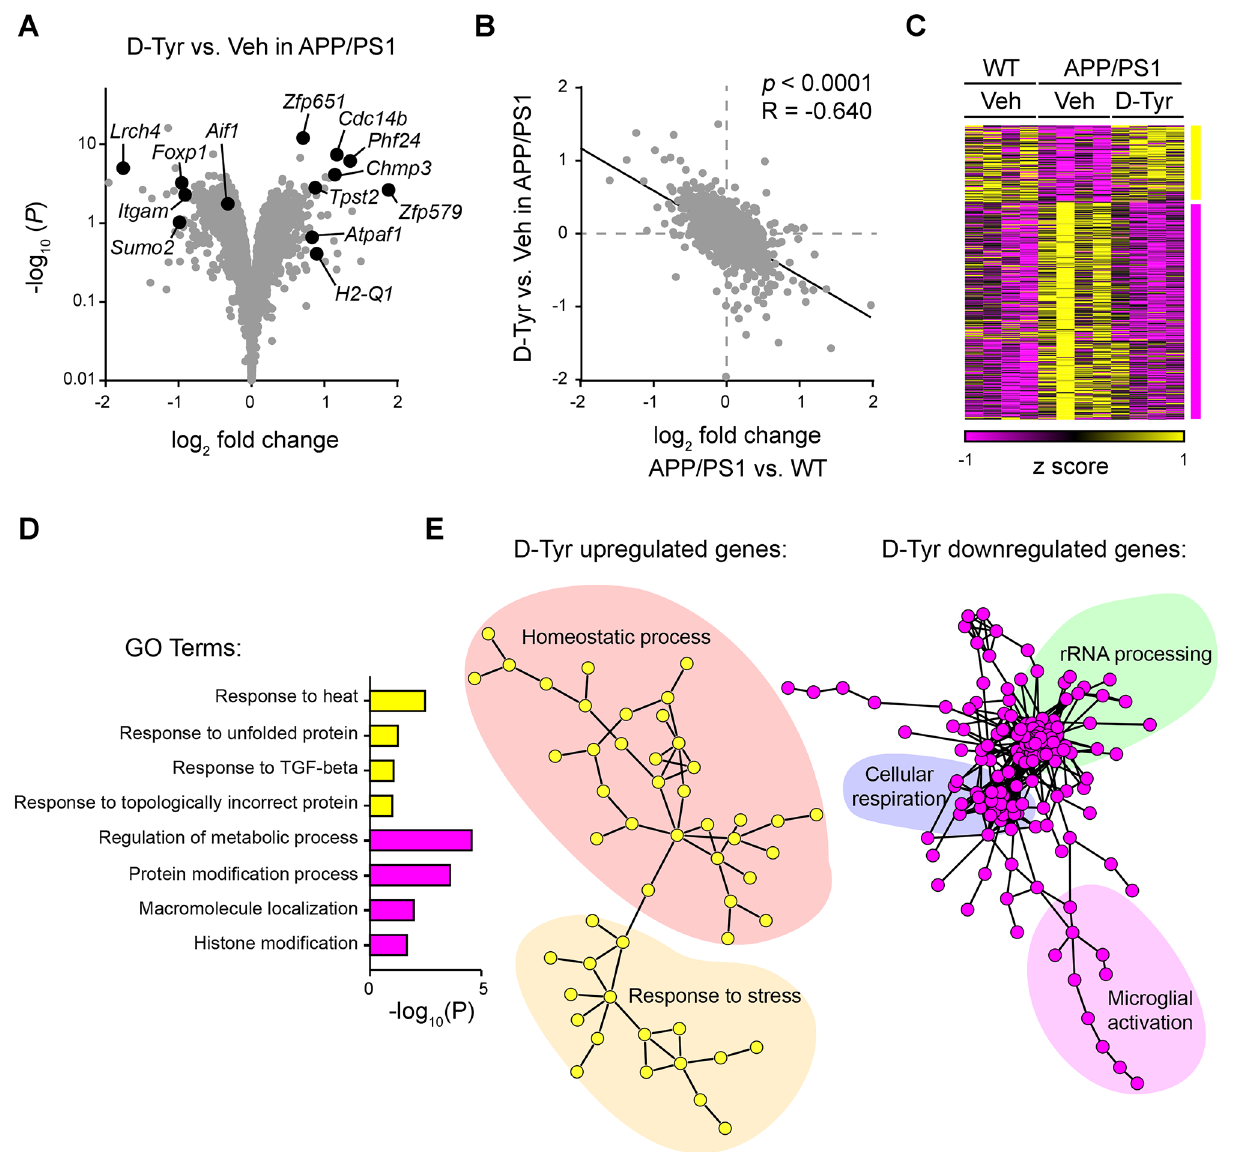
Figure 5. Administration of d-Tyr restores the dysregulated transcriptomic signature in APP/PS1 mice. ( A ) Volcano plot showing the differentially expressed genes (DEGs) upon d-Tyr administration in APP/PS1 mice. ( B – C ) d-Tyr administration reverted the transcriptomic changes in APP/PS1 mice. ( B ) Correlations between global transcriptomic changes of d-Tyr- versus vehicle (Veh)-treated APP/PS1 mice and APP/PS1 versus WT mice (r = − 0.64, p < 0.0001; linear regression). ( C ) Heatmap showing the expression levels of DEGs in d-Tyr- versus Veh-treated APP/PS1 mice, and Veh-treated WT mice. ( D – E ) Pathway analysis demonstrating the functional associations of d-Tyr–induced DEGs with stress response, rRNA processing, cellular respiration, and microglial activation. ( D ) Gene Ontology (GO) pathway analysis and ( E ) STRING protein–protein interaction analysis of the DEGs upon d-Tyr administration in APP/PS1